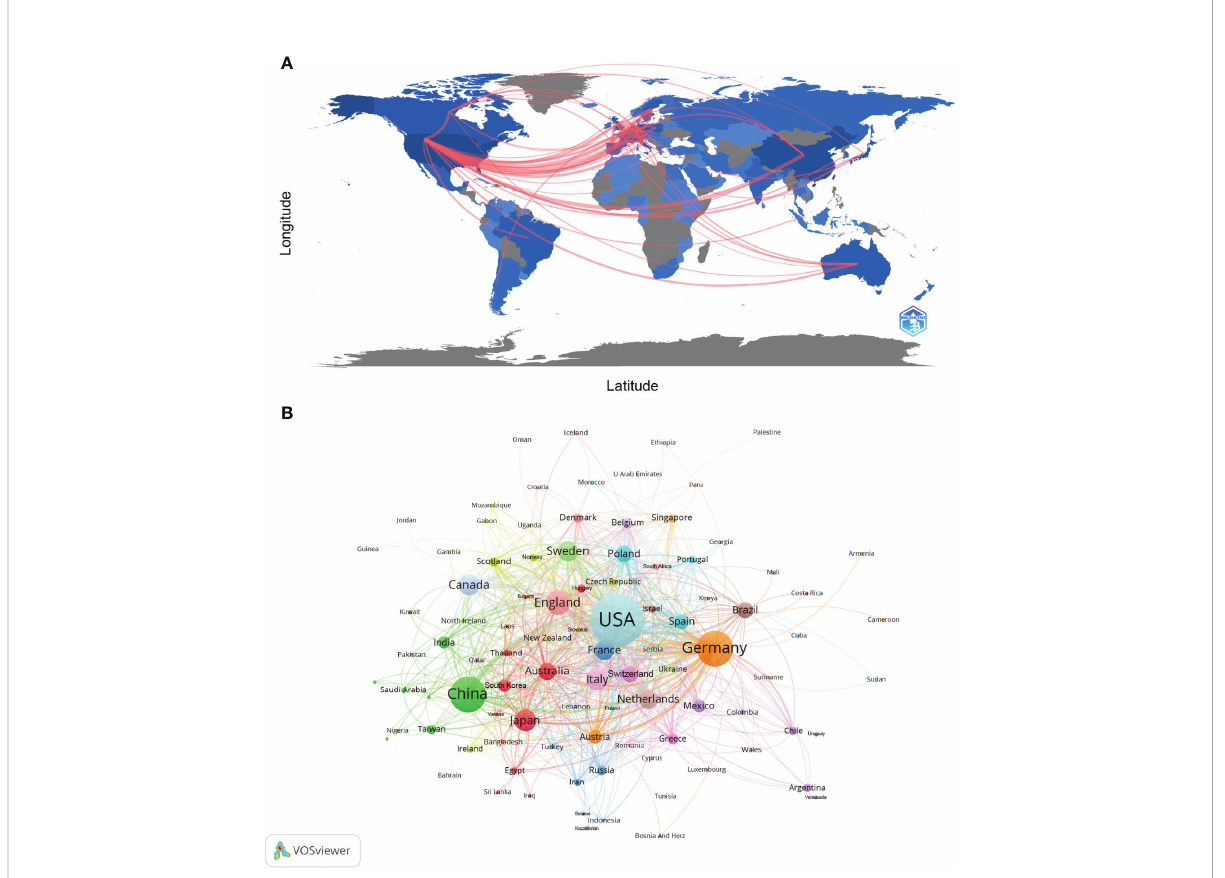
FIGURE 2 Analysis of NETs-related country/region. (A) Countries/regions involved in NETs-related research. The links between countries/regions indicate their collaborations and connections. (B) Analysis of collaborative network visualization of countries/regions in VOSviewer. The fi gure shows the countries/regions with more than 1 number of documents. The nodes of different colors represent the countries/regions with different clusters, and the size of the nodes indicates their node